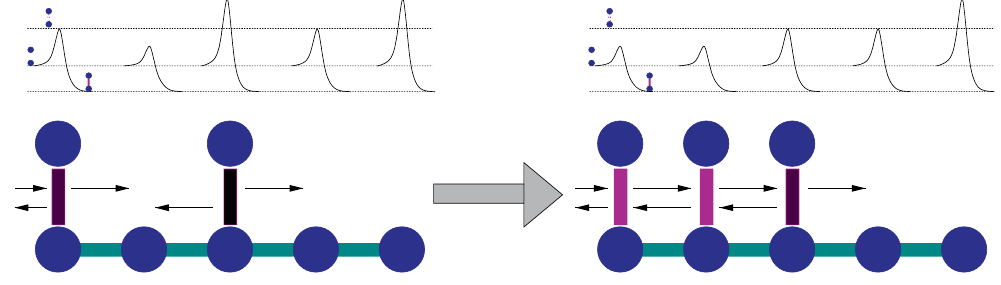
right is always reduced, whereas, the barrier for formation of the left neighbor is always higher. The asymmetric cooperativity mode is the same in both the cases (a) and (b) in the figure, since the mode is dictated primarily by the directionality of the single template strand, denoted by the thick black arrows below the strands in the fig- ure. Our assumption about the strength of sequence-independent cooperativity, in comparison with the weaker sequence-dependent cooperativity, leads to the former dominating the latter and dictating the asymmetric coop- erativity mode in single template strands. Our above choice of the dependence of asymmetric cooperativity mode on the directionality of template strand ensures that the DNA daughter strand construction beginning at its 5 ′ end and moving towards 3 ′ end (towards the right in Fig. 2(a,b)) is kinetically favored, while construction begin- ning from the 3 ′ end of the daughter strand is disfavored. This premise is borne from the observation that DNA daughter strand construction is unidirectional and proceeds from its 5 ′ end.